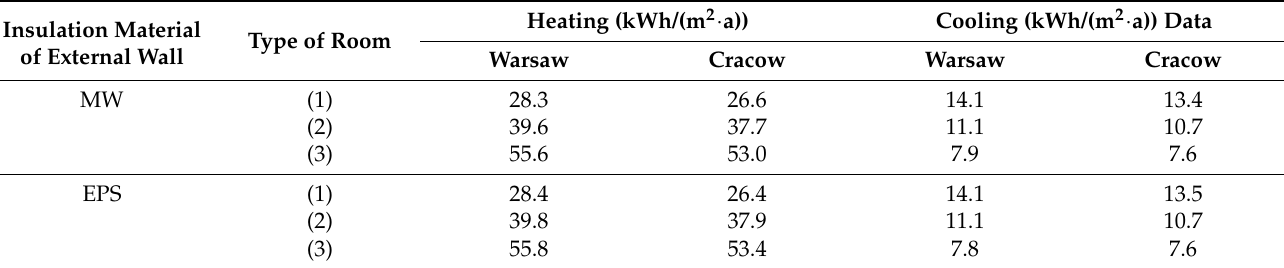
Table 6. The value of usable energy for individual